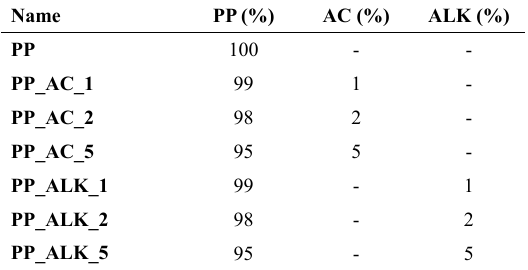
Table 1. Sample nomenclatures and